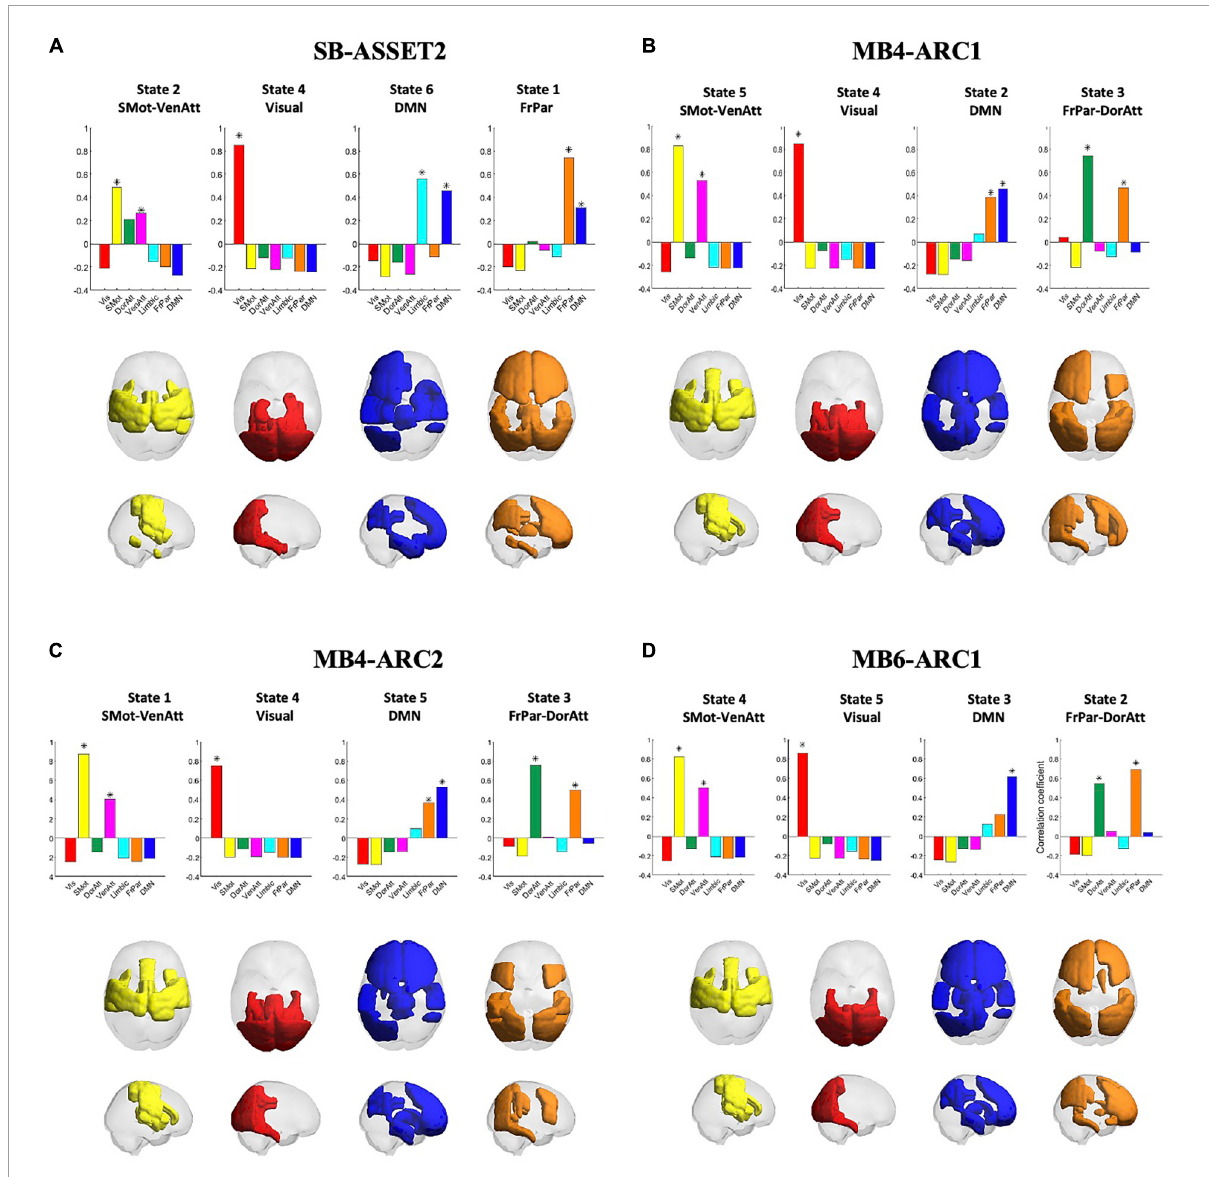
FIGURE2 Consistency of cluster centroids detected across modalities. The four panels represent the patterns detected in each fMRI acquisition modality, namely SB-ASSET2 (A) , MB4-ARC1 (B) , MB4-ARC2 (C) , and MB6-ARC1 (D) . Bar graphs at the top of each panel report the Pearson’s correlation coefficients between the patterns representative of each state and seven functional networks used as reference defined by Yeo et al. (2011). Each state is represented by rendering the subset of brain areas with positive values in the leading eigenvector of that state on a transparent cortex displayed in axial and saggital views. Vis, visual network; SMot, somato-motor network; DorAtt, dorsal attention network; VenAtt, ventral attention network; FrPar, frontoparietal network. *Represents a significant correlation between a given state and a Yeo